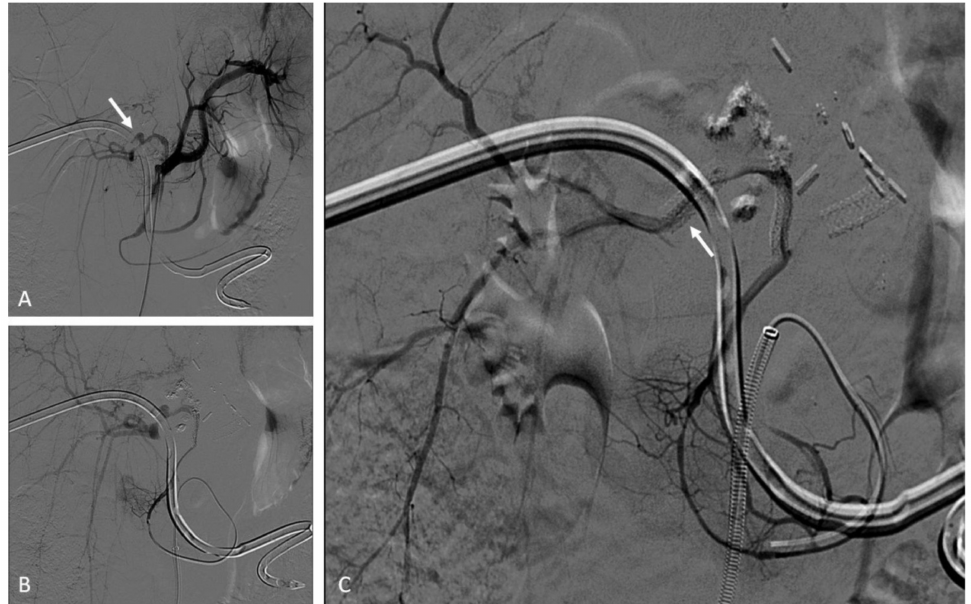
Figure 8. Transcatheter repair with coronary stent graft of a hepatic artery pseudoaneurysm after liver transplant and percutaneous biliary drainage in a 9-year-old female presenting with hemobilia. ( A ) DSA image shows a small pseudoaneurysm (arrow) of the hepatic artery close to the percutaneous biliary drainage catheter. The common hepatic artery is thrombosed, and the proper hepatic artery is revascularized through the gastroduodenal artery, due to a previous endovascular procedure for anastomotic stenosis. ( B ) DSA image shows superselective coaxial 1.9F microcatheterization of the gastroduodenal artery through a 5F introducer sheath and a 5F coaxial guiding catheter placed at the origin of the superior mesenteric artery. ( C ) Control DSA, performed after deployment of a coronary 3-mm balloon expandable stent graft (arrow), shows regular opacification of the artery and disappearance of the